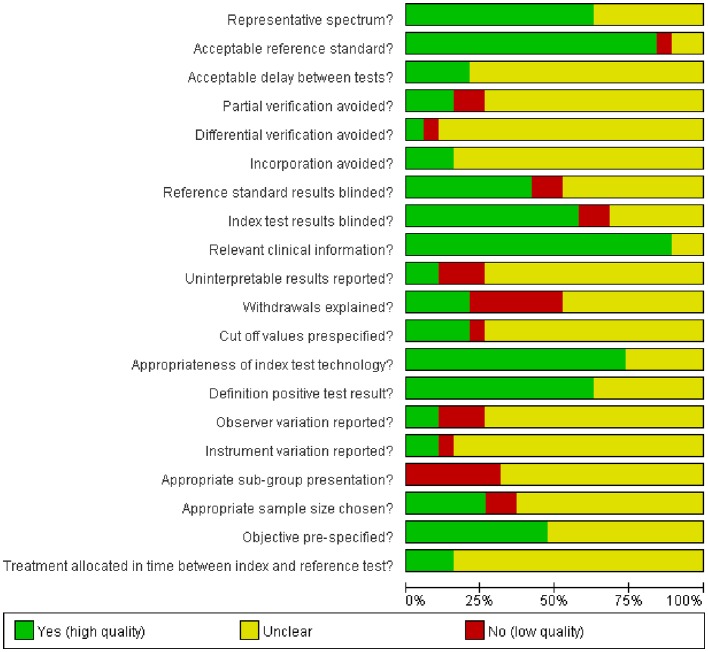
The assessment of methodological quality items shown as percentages across all included studies.